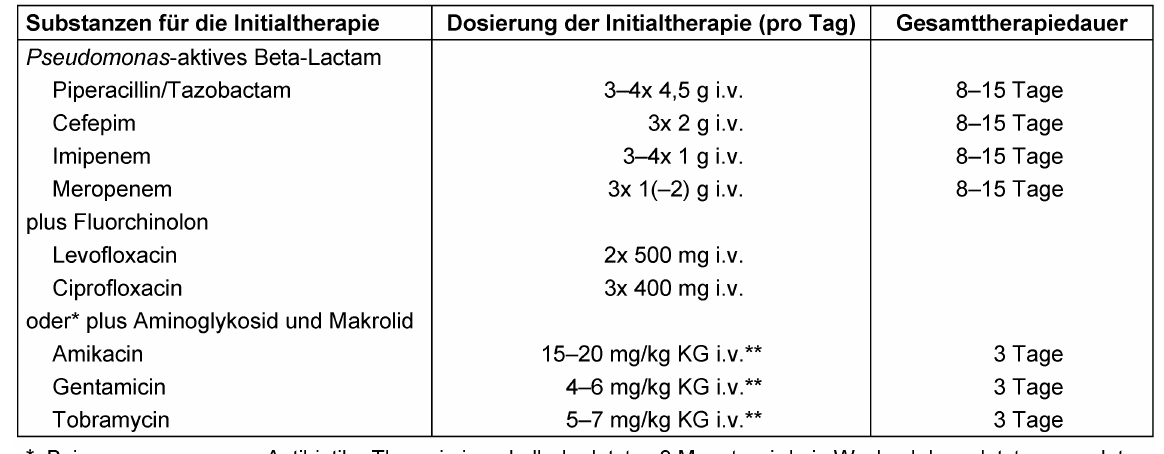
für multiresistente Erreger